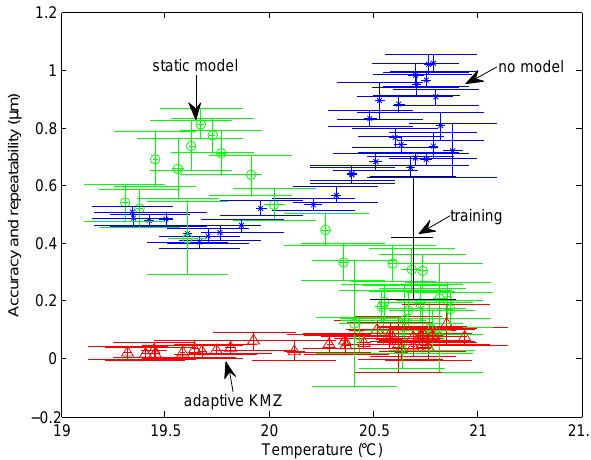
Figure 14. Relationship between temperature and accuracy and